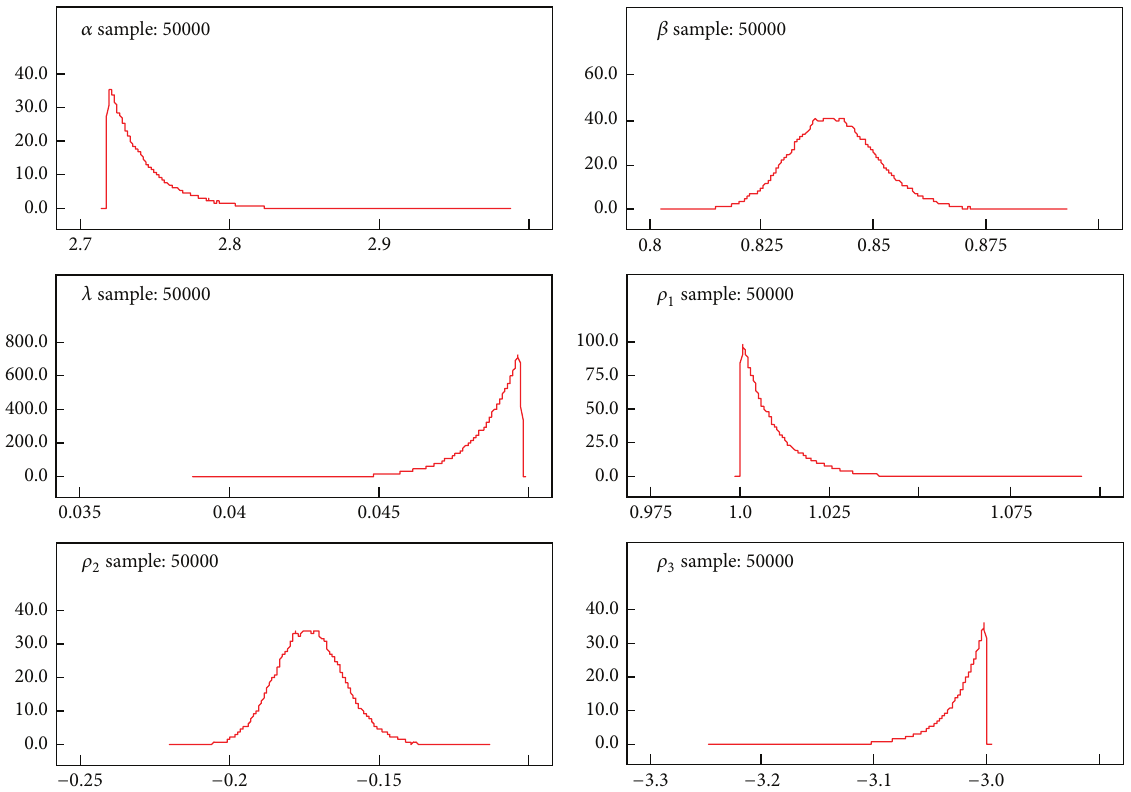
Figure 4: Kernel density of the posterior parameters for the exponentiated Weibull for Black Hispanic females breast cancer patients ( 𝑛 = 298